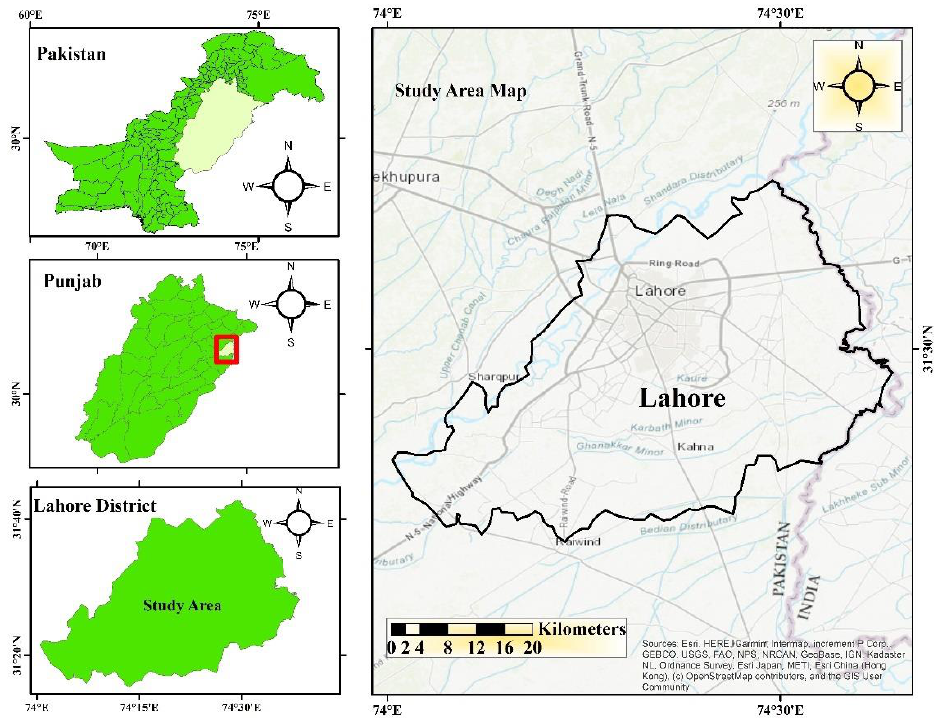
Figure 1. Study area map. Red box indicates the study area location in Punjab Province of Pakistan